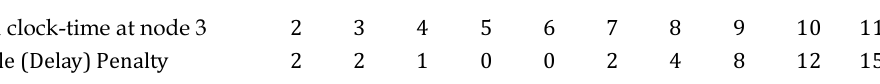
Penalty for early/late arrival at the leg destination Arrival clock-time at node 3